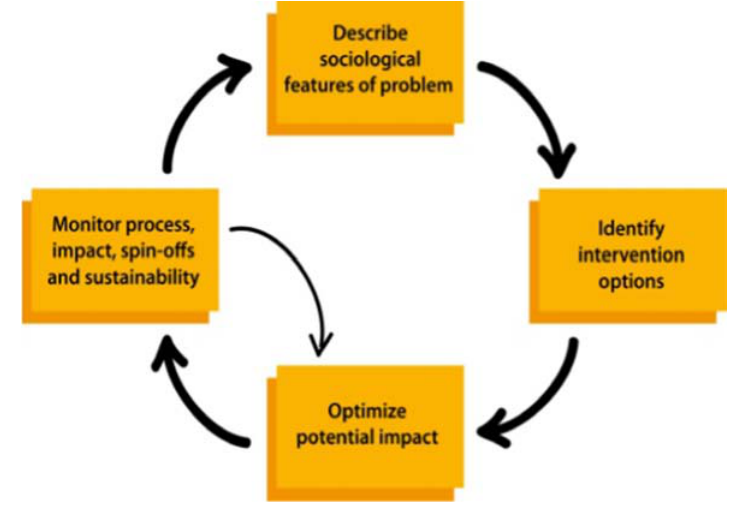
Figure 2. Multiple intervention framework (Edwards, Mill & Kothari,